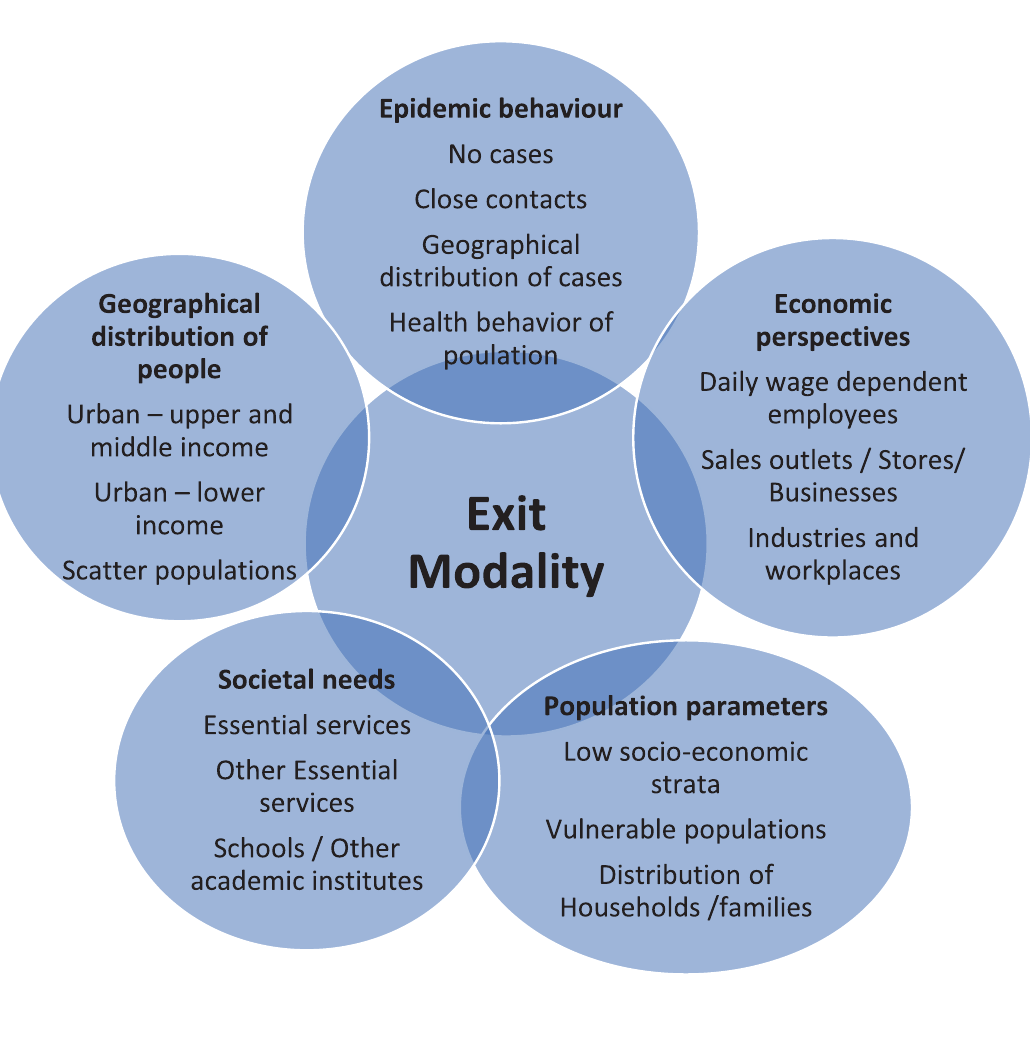
Figure 2: Parameters to be considered in an exit